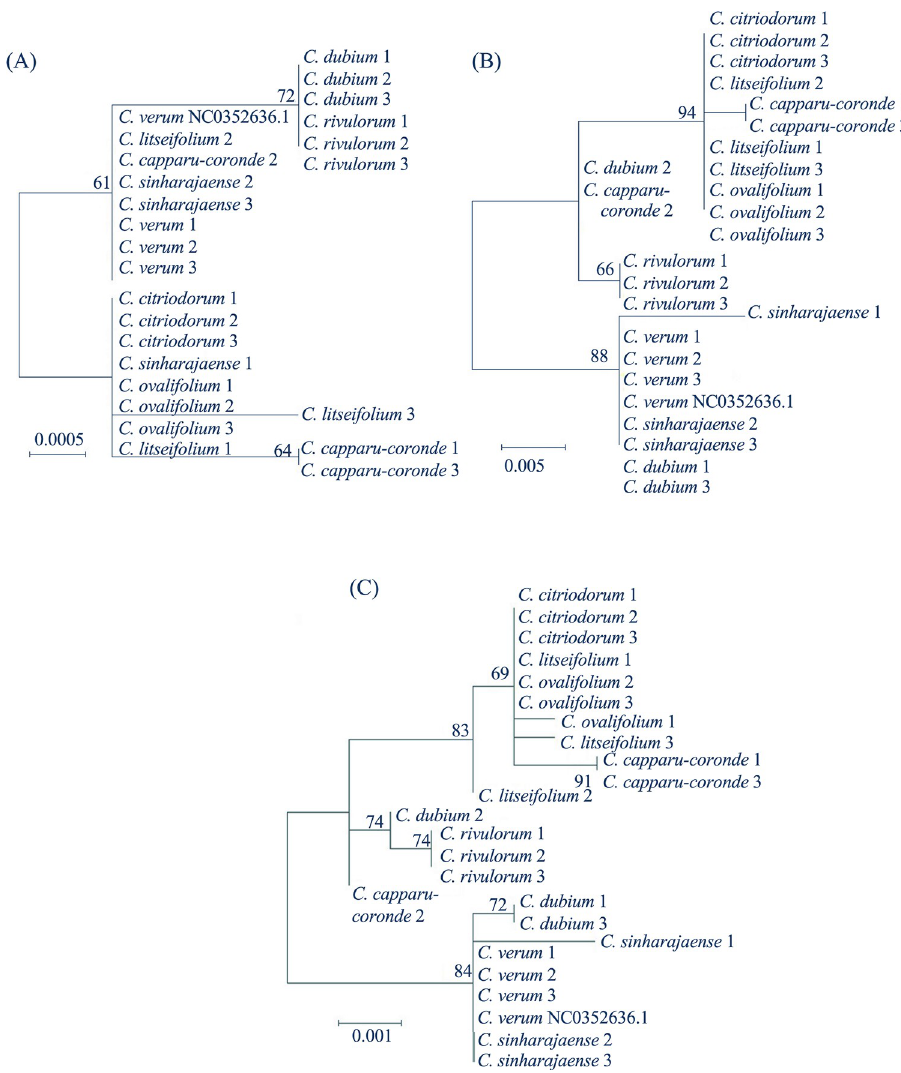
Fig 1. Maximum likelihood trees (unrooted) inferred from DNA barcode data for Cinnamomum species. (A) matk (B) trnH-psbA (C) combined data sets of rbcL, matK, and trnH-psbA regions. Values on branches represent bootstrap